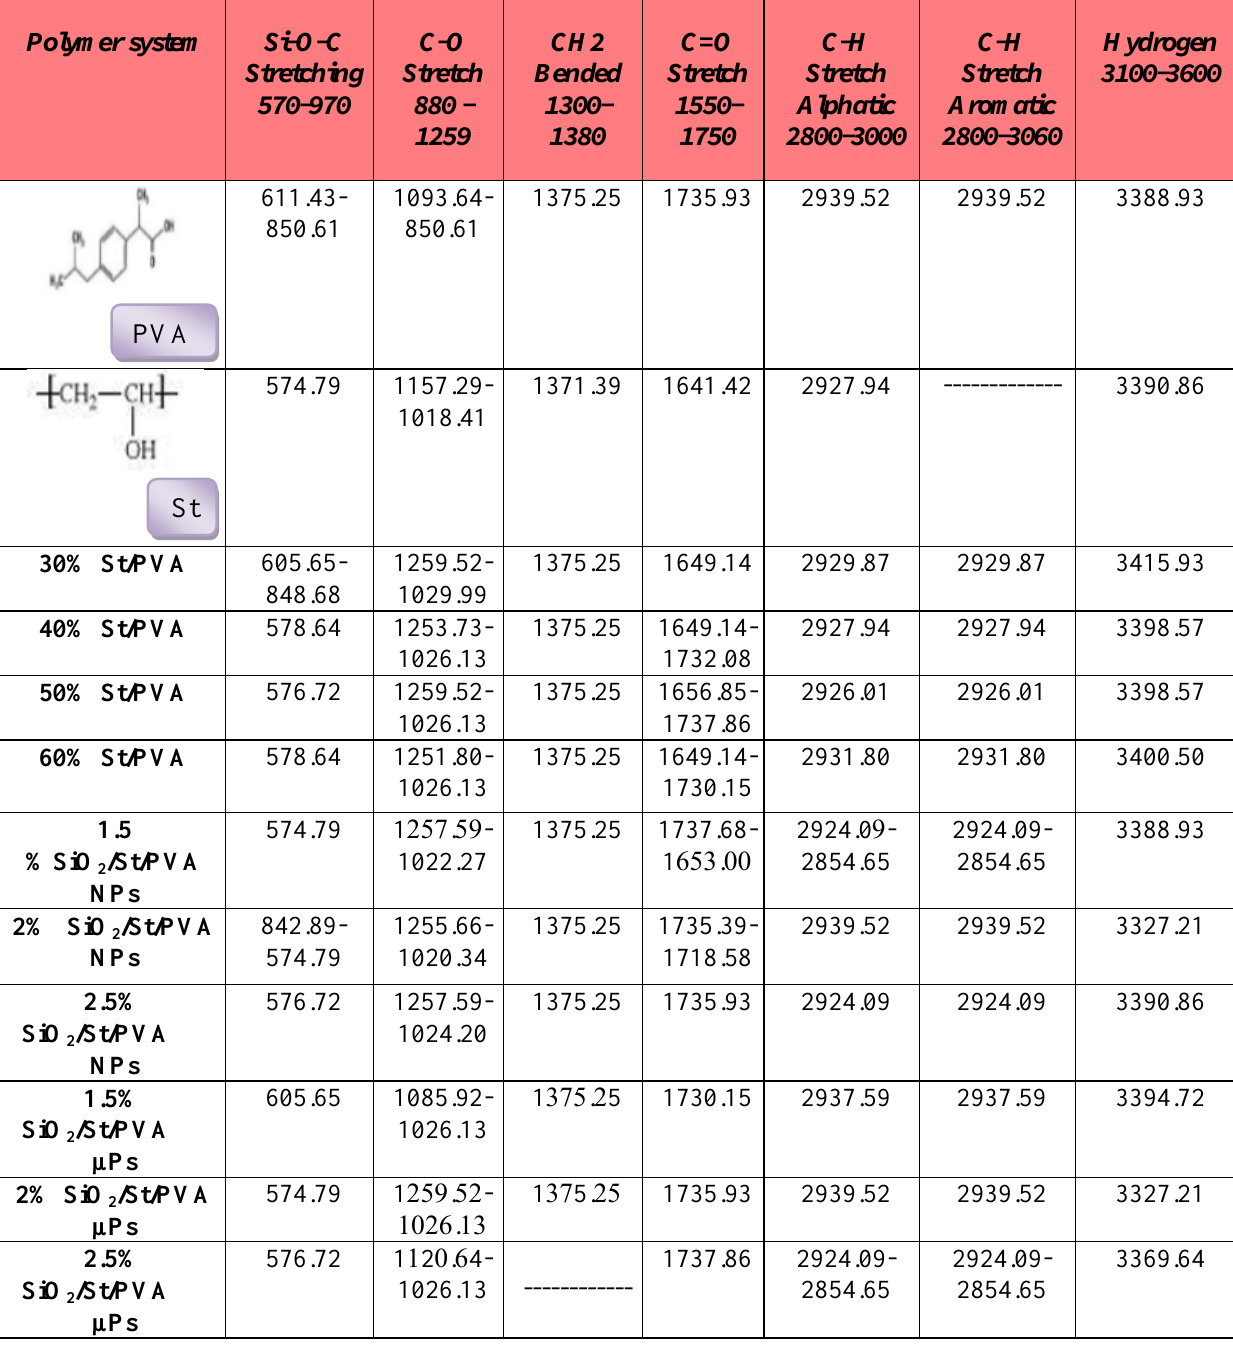
Table 1: show FTIR-characteristic